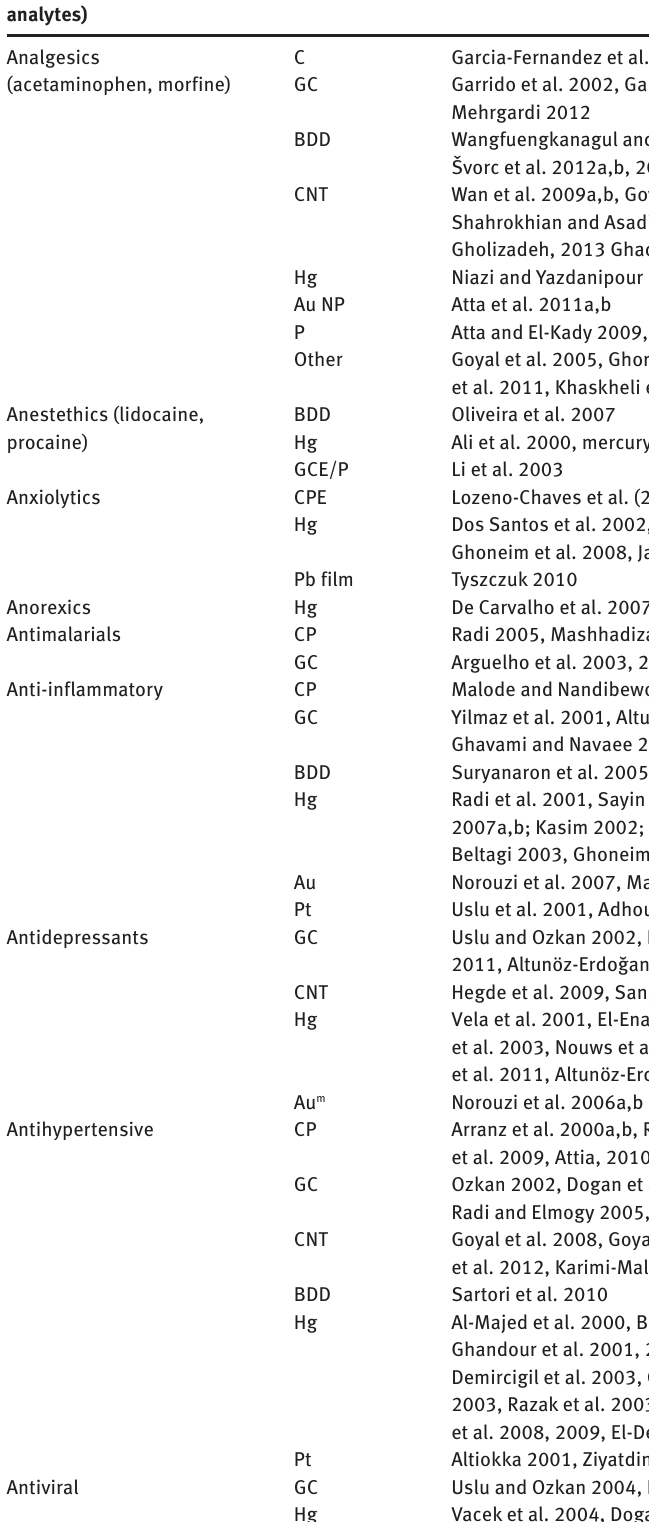
Table 3 Voltammetric methods for the screening of important families of chemicals in pharmaceutical formulations and biological fluids reported since